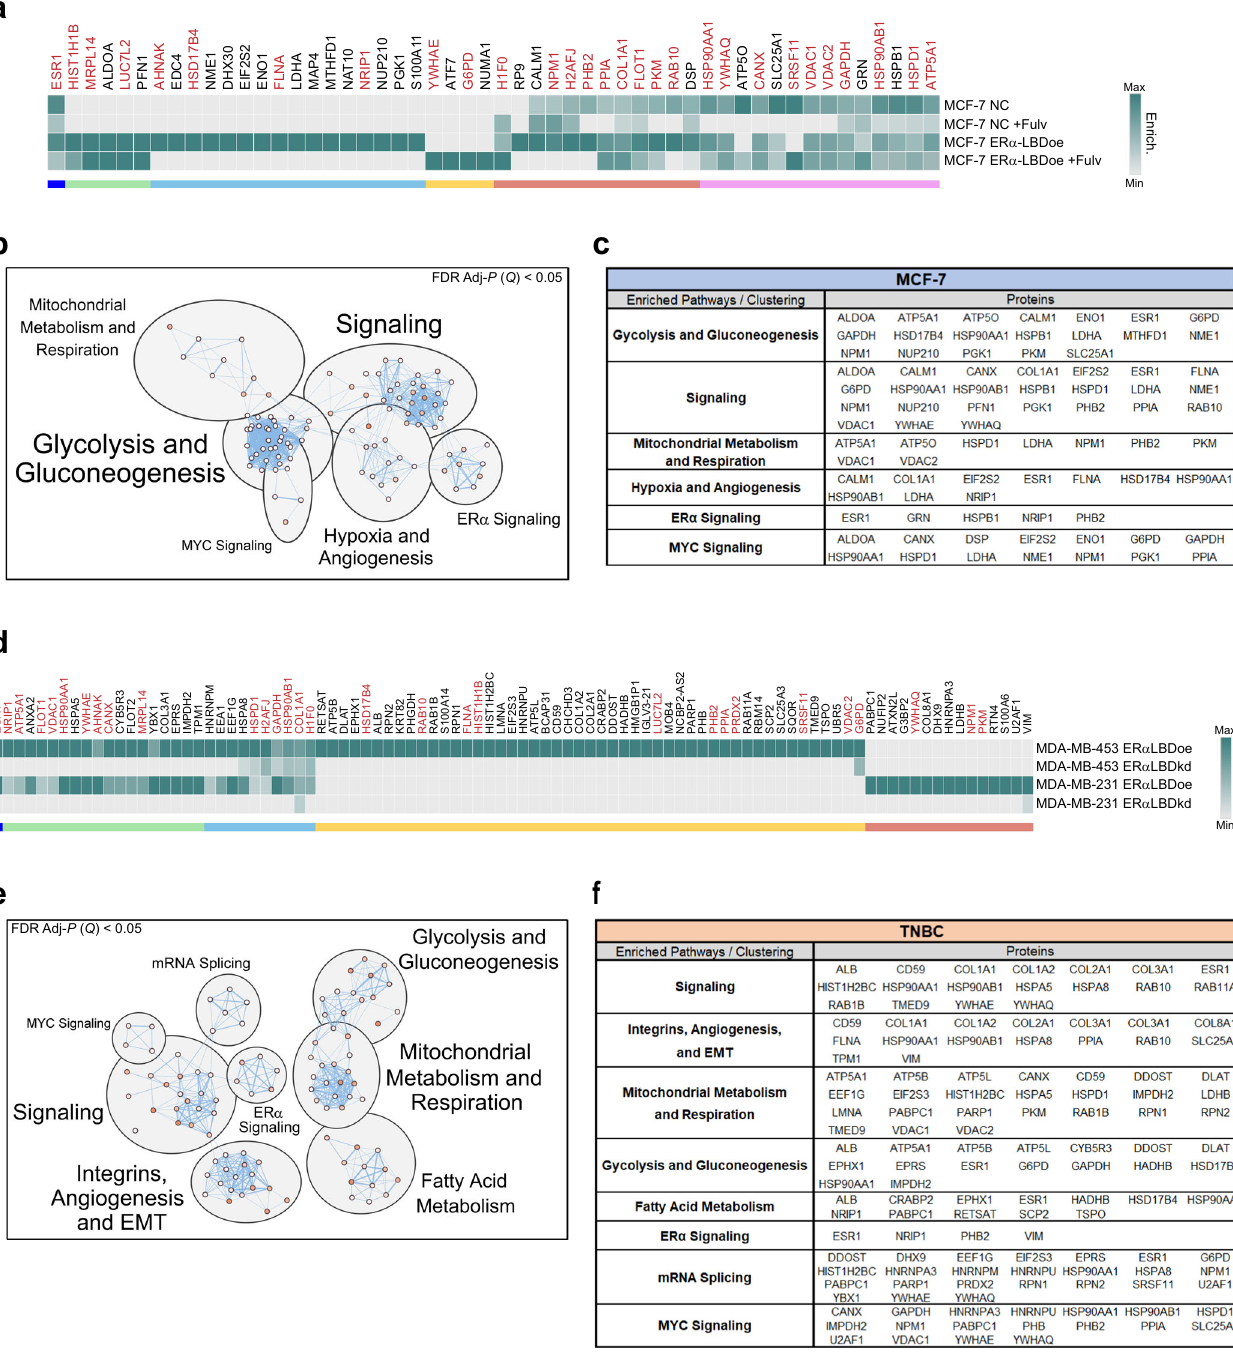
Fig. 4 Predicted ER α -LBD network: protein – protein interactions (PPIs) and biological pathways. a Heat map showing the enrichment level of proteins that preferentially bind ER α -LBD, based on ER α co-immunoprecipitation (Co-IP) experiments followed by LC/MS analysis. Samples: NC and NC + Fulv (negative controls); ER α -LBDoe, ER α -LBDoe + Fulv (overexpression). Fulv = 1 µM fulvestrant treatment, 24 h. Different comparative criteria between samples were used to identify groups of ER α -LBD protein interactors, color-coded as follows: ER α (blue); proteins present only in ER α -LBD samples (green, cyan and yellow); proteins enriched more in ER α -LBD samples compared to NC, in the absence or presence of fulvestrant treatment (red and purple, respectively). Protein names labeled in dark red color are shared between MCF-7 and TNBC models (see below). b ‘ Enrichr ’ platform based on multiple libraries was used to discover cell pathways in which ER α -LBD PPIs are signi fi cantly involved (Adj- P ( Q ) < 0.05, FDR test), then clustered and annotated by using Cytoscape software and MCL algorithm. c ER α -LBD PPIs contribution to clustered pathways. d Same as in a . Samples: MDA-MB-453/-231 ER α -LBDoe (overexpression); MDA-MB-453/-231 ER α -LBDkd (knockdown). ER α PPIs and protein groups, color-coded as follow: ER α (blue); proteins enriched in both TNBC cell lines overexpressing ER α - LBD, compared to ER α -LBD silenced cells (green and cyan); enriched in MDA-MB-453 ER α -LBDoe cells only (yellow); enriched in MDA-MB-231 ER α -LBDoe cells only (red). e , f Same as in b , c . Source data are provided as Supplementary Data 4 fi